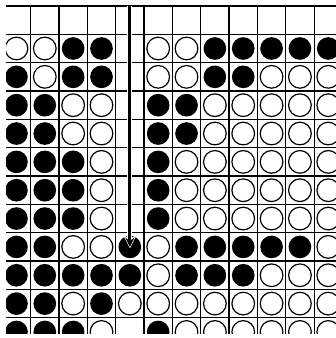
Figure 57. BLACK